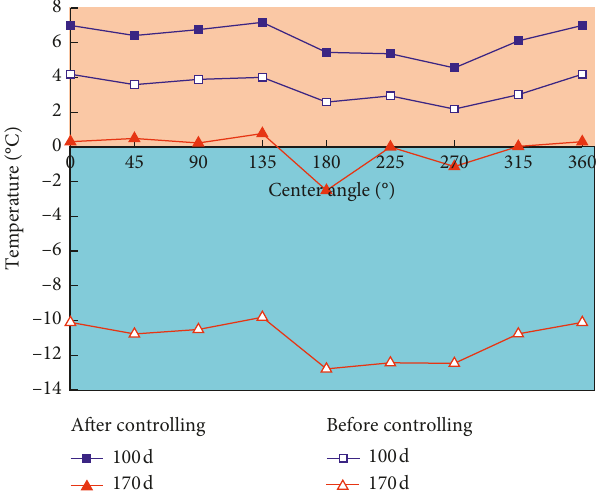
Figure 11: Predicted temperature of the shaft wall at the − 300m layer in various